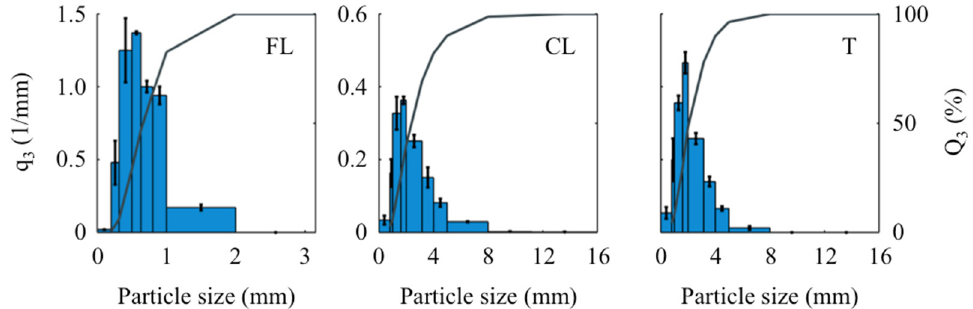
Figure 3. Histogram (blue columns) of the density distribution (primary x -axis) and line chart of the cumulative distribution (secondary x -axis) of the particle size distribution of the di ff erent particle types (FL, CL, and T, where CL and T have the same axis scales) obtained by sieve analysis. Table 4. Characteristic values of the particle size distribution after sieve analysis and their coe ffi cient of variance (in brackets) over the repeat measurements with results (homogeneous groups, indicated by letters) of statistical mean value comparison for the core layer particles CL and T. (MV = mean